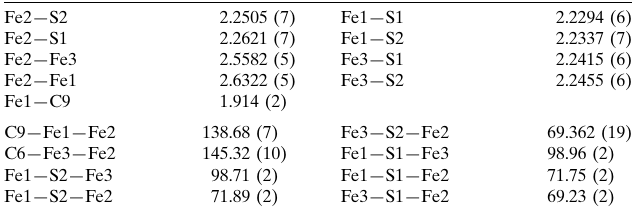
Selected geometric parameters (A˚ , (cid:1)